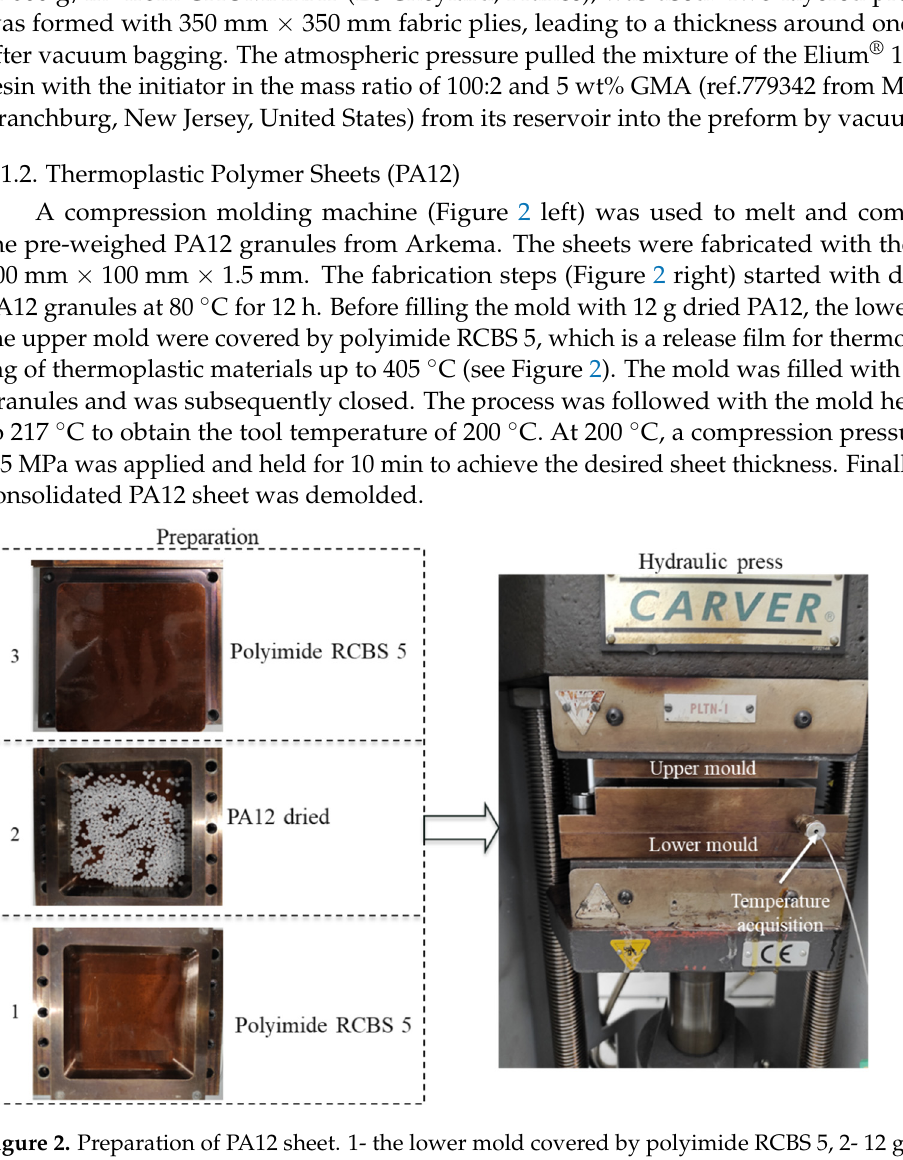
Figure 3. Masked Elium ® -GMA glass fiber composite (EMG) film preparation. All dimensions are in mm. The assembly was started with stacking the first layer of polyimide RCBS5, a masked Elium ® -GMA plate, a PA12 sheet, a masked Elium ® -GMA plate, and the last layer of pol- yimide RCBS5 (Figure 4).